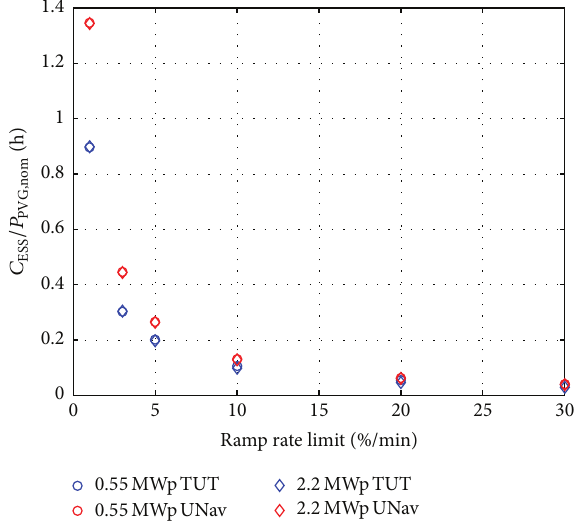
Figure 5: Energy capacity requirement for ESS as a function of the ramp rate limit for two sizes of PV generators located at Tampere region in Finland and Navarra region in Spain [9]. Capacities are normalized to the generators nominal